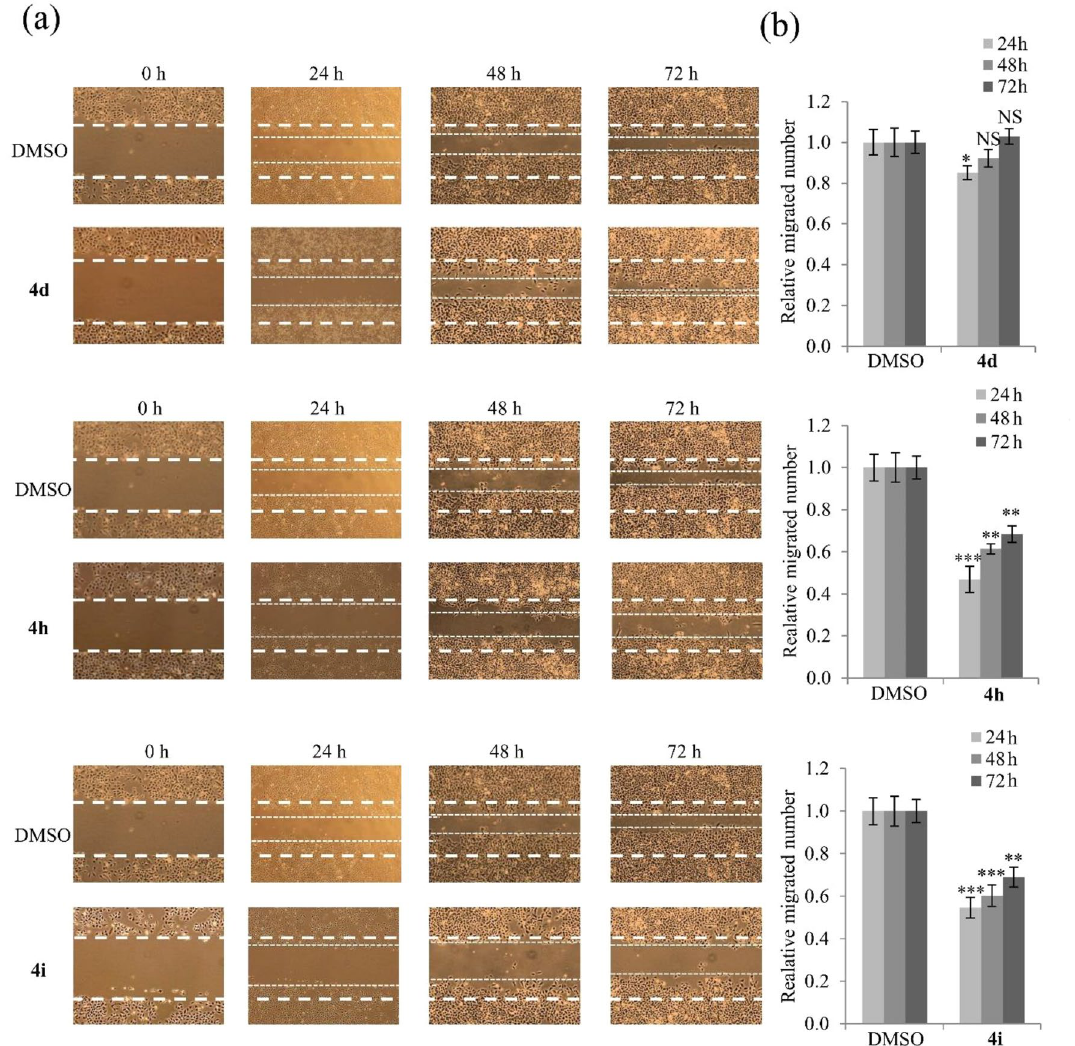
Figure 5. Inhibition of A549 cell migration by compounds 4d , 4h , and 4i . ( a ) Representative images and ( b ) quantitative analysis of migration assays of A549 cells treated with 15 μM compounds 4d , 4h , and 4i for 24, 48, and 72 h. Representative images from three independent experiments are shown (n = 3). Data represent the mean ± SD. * p < 0.05; ** p < 0.01; *** p < 0.001; NS, no significant difference compared with DMSO-treated A549